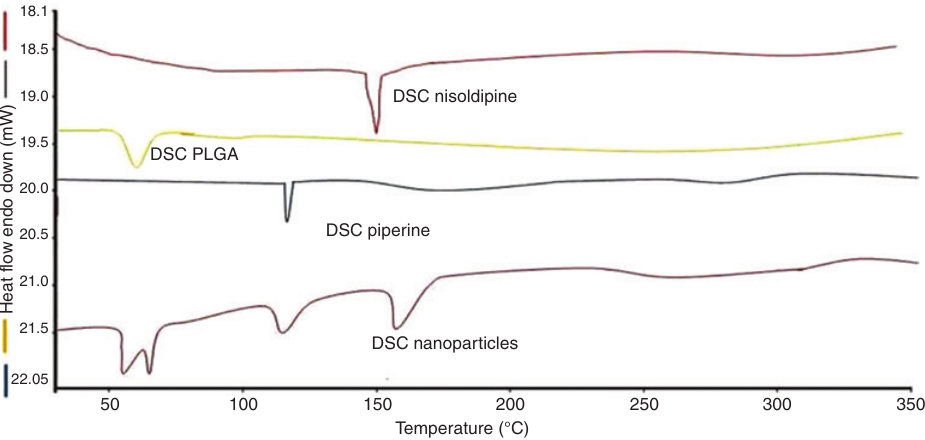
Figure 3: Comparison of DSC of ingredients and